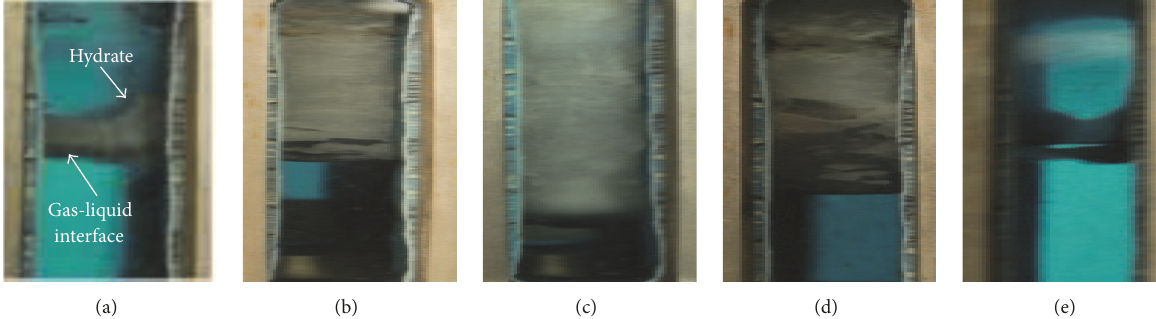
Figure 2: The formation and dissociation process of hydrate. (a) Initial hydrate formation, (b) hydrate growth rapidly, (c) formation ending stage, (d) hydrate decomposition gradually, and (e) hydrate formation for the second